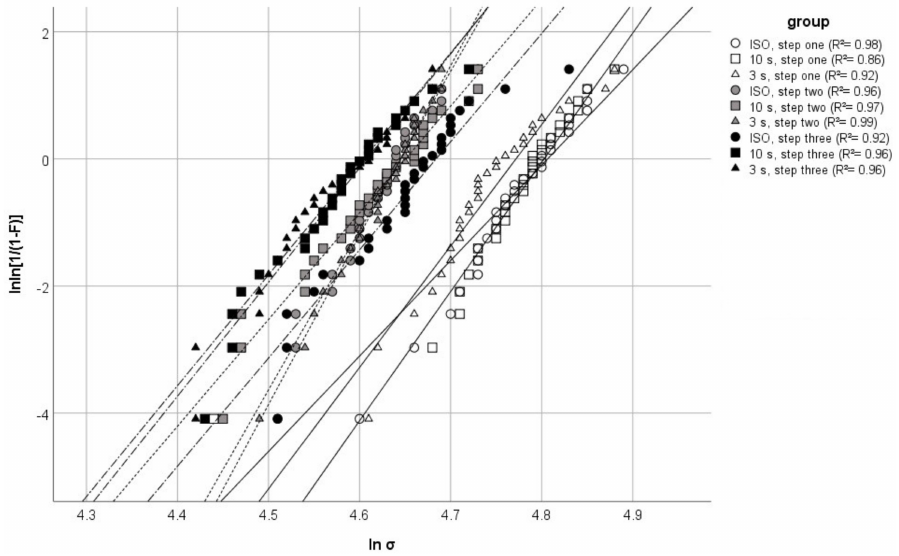
Figure 2. Weibull distribution as a function of curing and aging.